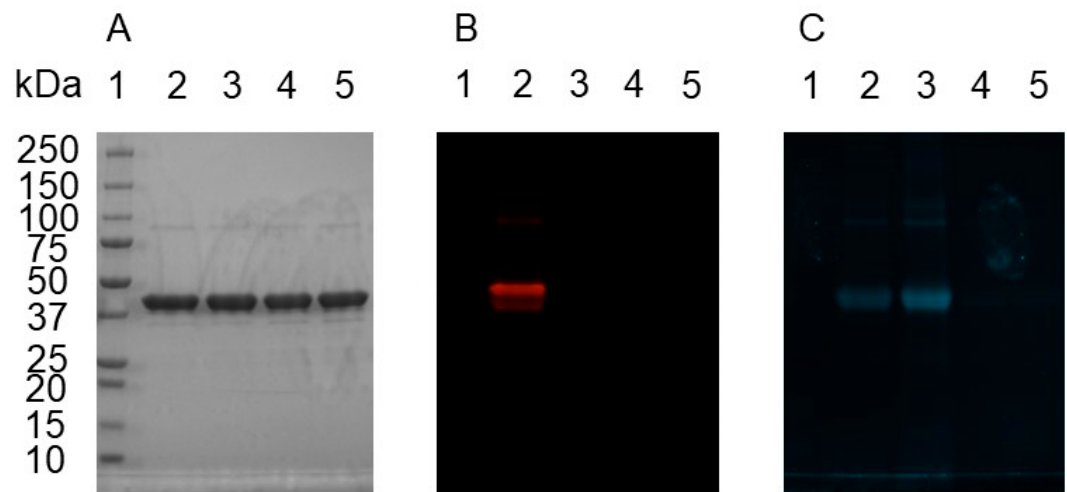
Figure 5. SDS PAGE analysis of protein conjugates obtained after first reacting 15 with rhodamine B azide (RhB-N 3 ) in the CuAAC reaction, followed by conjugation to MBP-dC10* by the FlARe reaction. ( A ) Coomassie stained gel showing MBP-dC10* bands. ( B ) Unstained gel excited with Green Epi Illumination and imaged using a 605 / 50 filter. ( C ) Unstained gel excited with Blue Epi Illumination and imaged with a 530 / 28 filter. Lanes: (1) Pre-stained protein standards (2) MBP-dC10* reacted with the 15 -RhB-N 3 product of the CuAAC. (3) MBP-dC10* reacted with 15 subjected to a mock CuAAC without RhB-N 3 . (4) MBP-dC10* incubated with RhB-N 3 under CuAAC conditions. (5) MBP-dC10*.